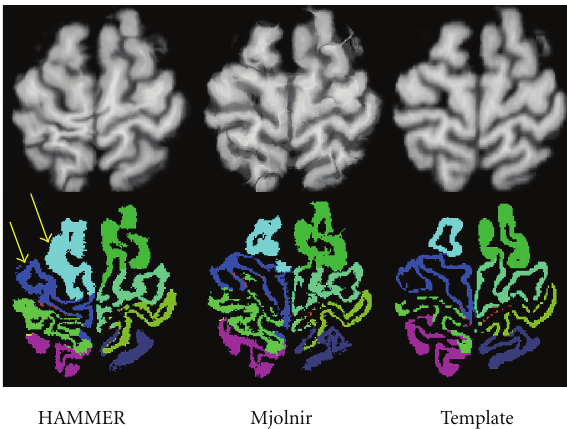
Figure 14: Example of an outlier occurring in HAMMER, where HAMMER’s ability to follow the folding pattern of the cortex is lacking. The top row shows the deformed MR images and the corresponding template image on the right. The bottom row shows the corresponding deformed labels from the NIREP Na0 database and the template’s